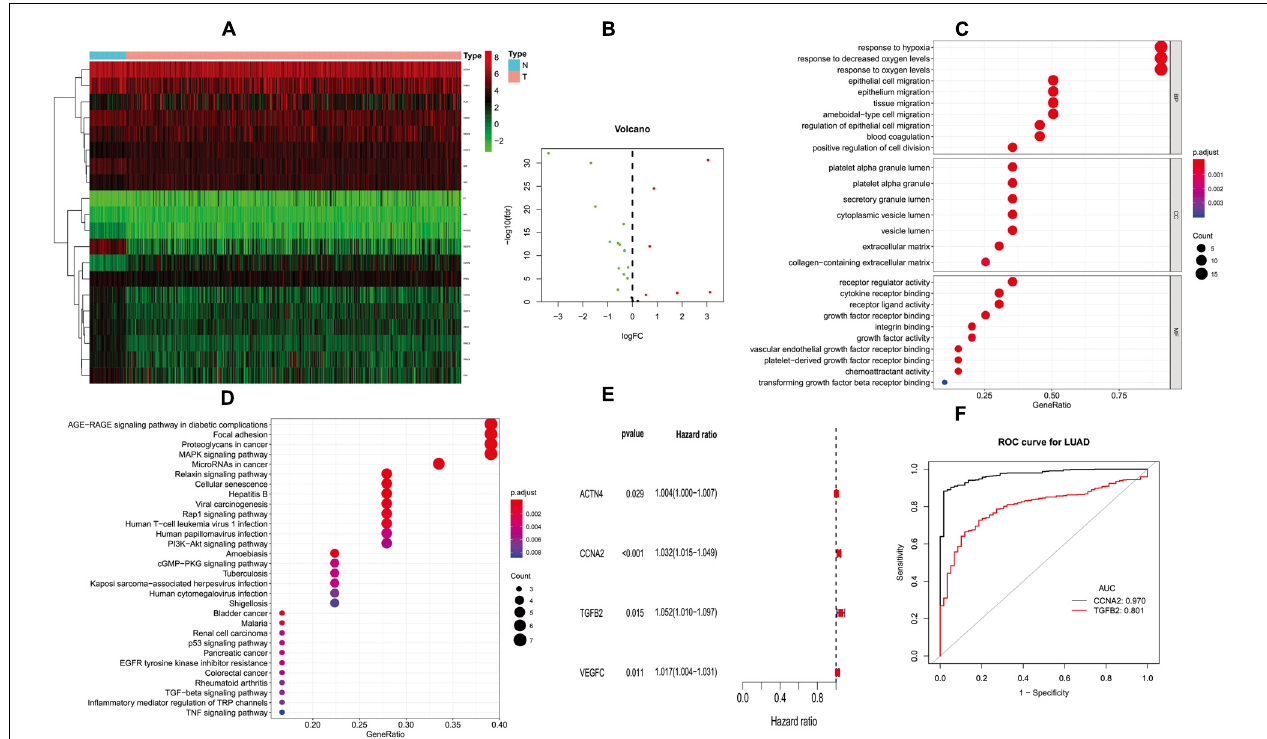
FIGURE 1 | Differentially expressed PM-related genes and identifying hub HMGB-1-related genes. (A) Heat map of differentially expressed PM-related genes in the TCGA; (B) volcano plot of differentially expressed PM-related genes in the TCGA; (C,D) GO and KEGG for differentially expressed PM-related genes; (E) single-factor analysis for differentially expressed PM-related genes. (F) ROC results for PM-related genes in diagnosis of lung adenocarcinoma. PM, platelet and immunity; TCGA, the Cancer Genome Atlas Dataset; GO, gene ontology; ROC, receiver operating characteristic.